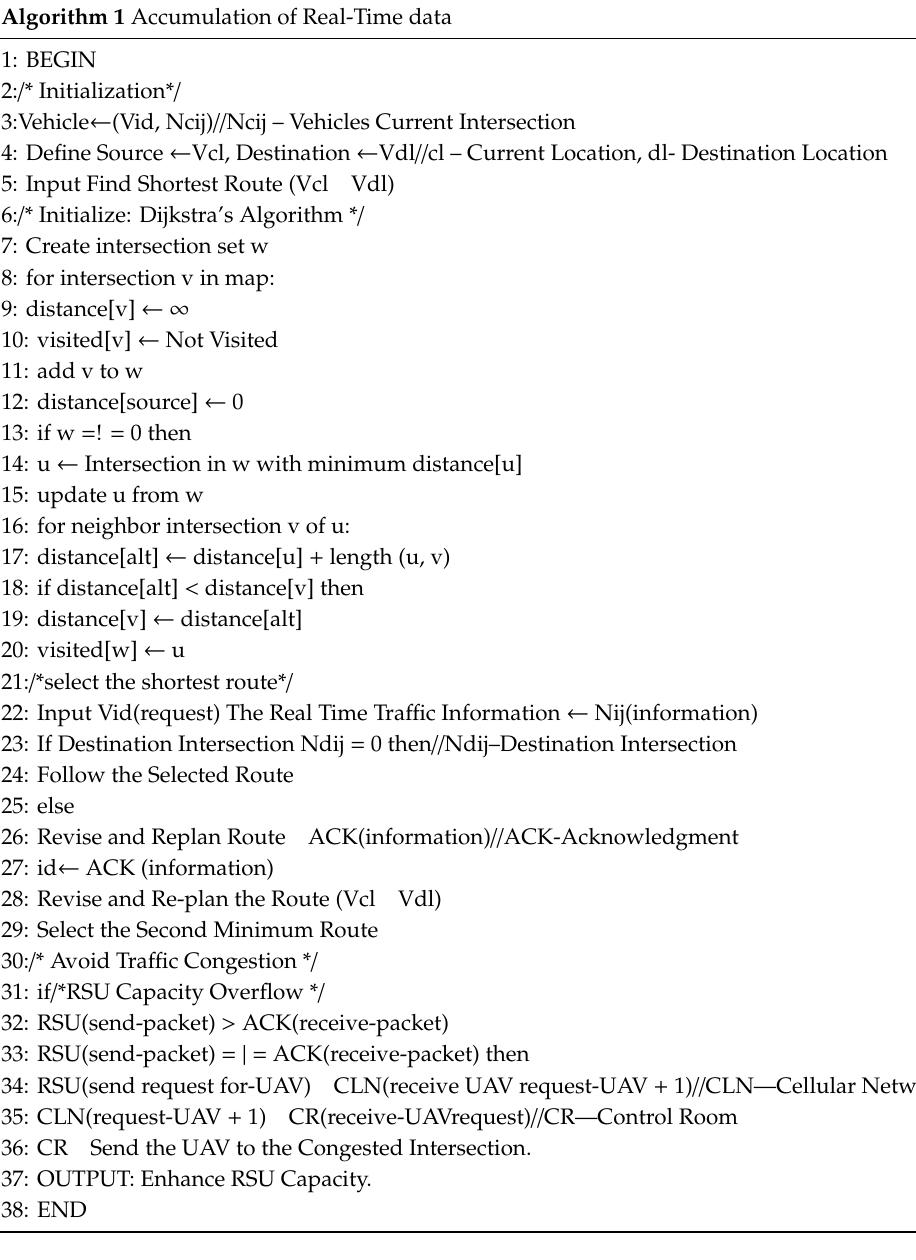
Algorithm 1 Accumulation of Real-Time